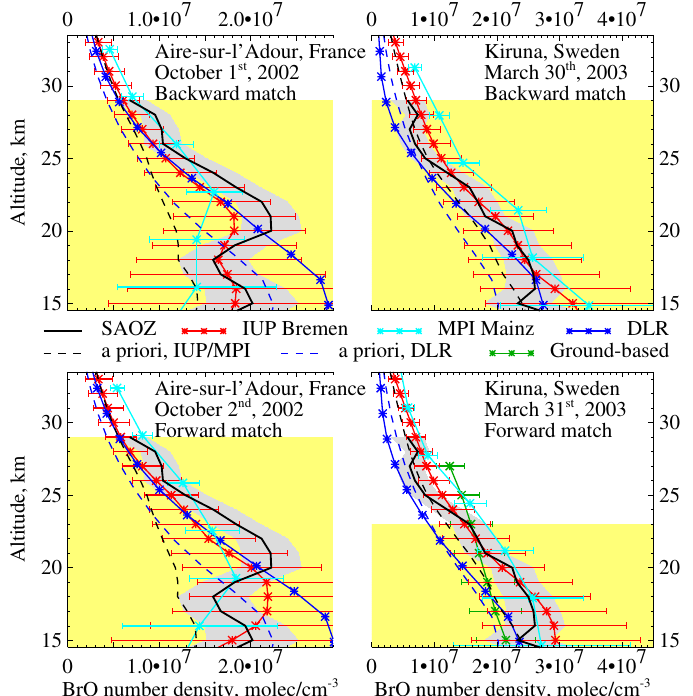
Fig. 25. Comparison of BrO vertical distributions retrieved from SCIAMACHY limb measurements using different retrieval algorithms to coinciding balloon-borne SAOZ observations. When available, ground-based UV-visible BrO profiles from the Harestua station are also shown. Left panels: balloon launch in Aire-sur-l’Adour (mid-latitude) on 1 October 2002. Right panels: balloon launch in Kiruna (high latitude, outside the polar vortex) on 30 March 2003. Gray shadings depict the uncertainties of SAOZ results (1- σ ). Yellow areas mark vertical ranges where according to trajectory model calculations both instruments probe the same air